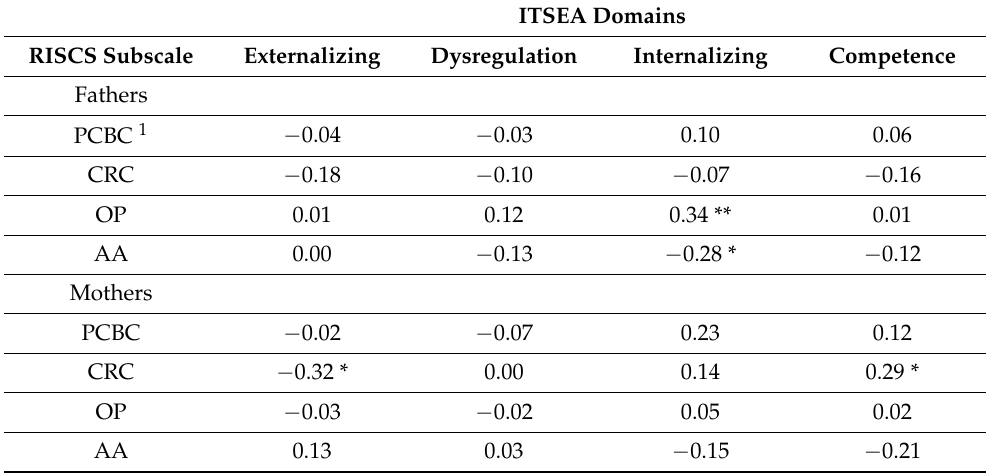
Table 3. Correlations between RISCS scores and toddler social-emotional